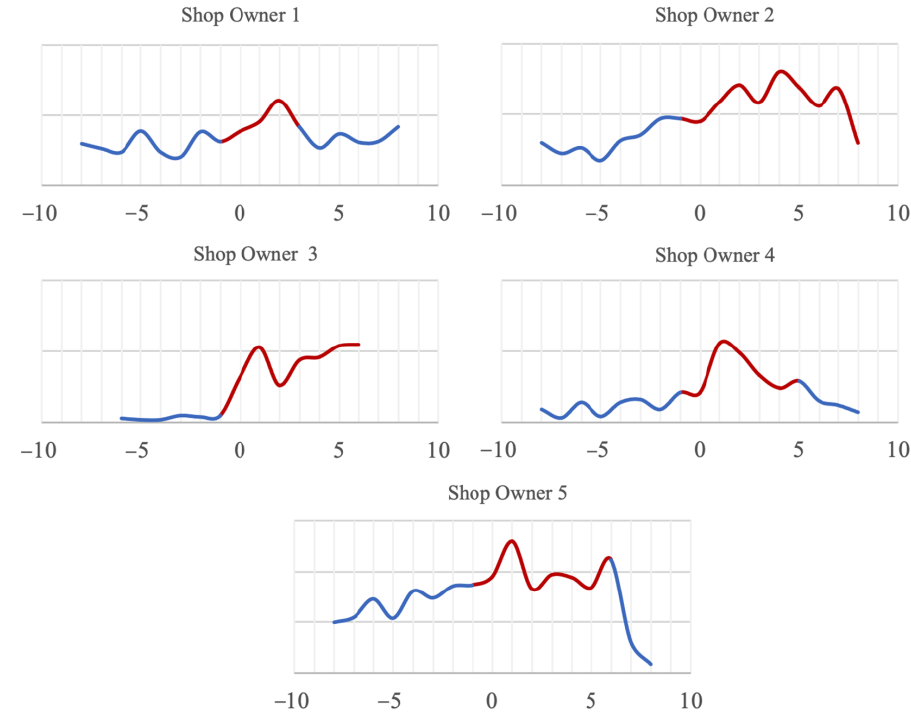
Figure 9. The curves of different shop owner’s commodities sales.